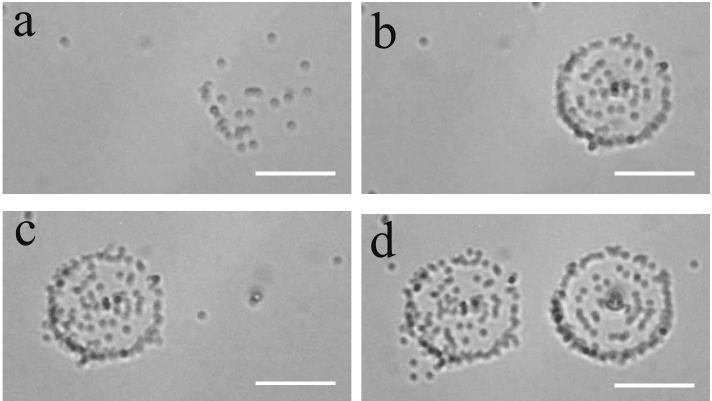
Figure 6. Images of forming two particle patterns by the diffraction pattern. ( a , b ) forming process of the first pattern. ( c , d ) forming process of the second pattern. The first pattern has been moved to the left. The 0.5 µ m particles’ concentration is 4 × 10 9 cm − 3 . The laser power is 820 mW; scale bar, 10 µ